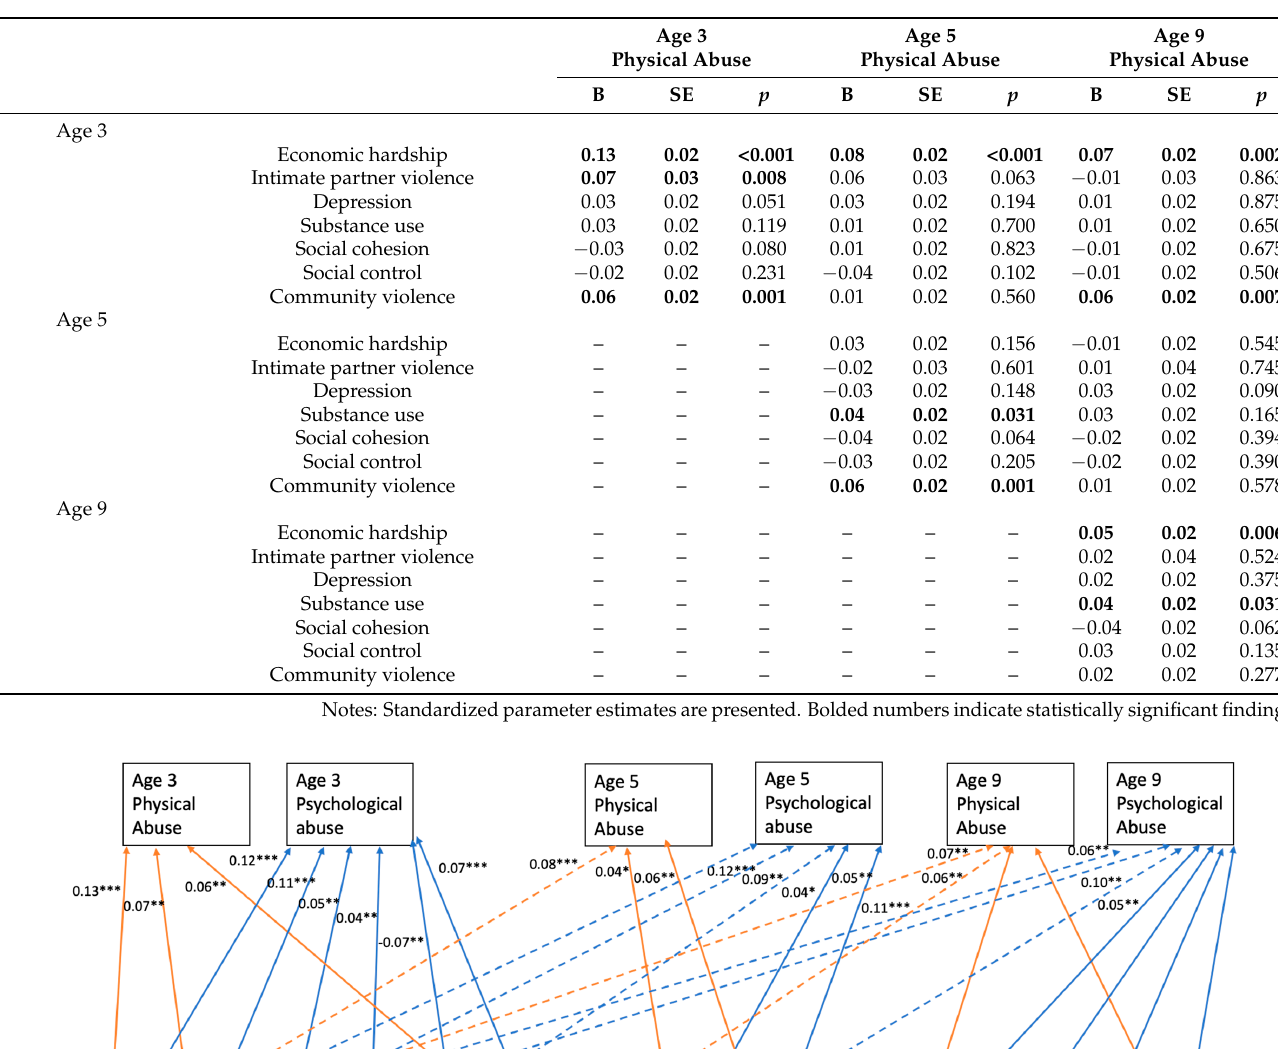
Table 2. Time-varying predictors of physical abuse.